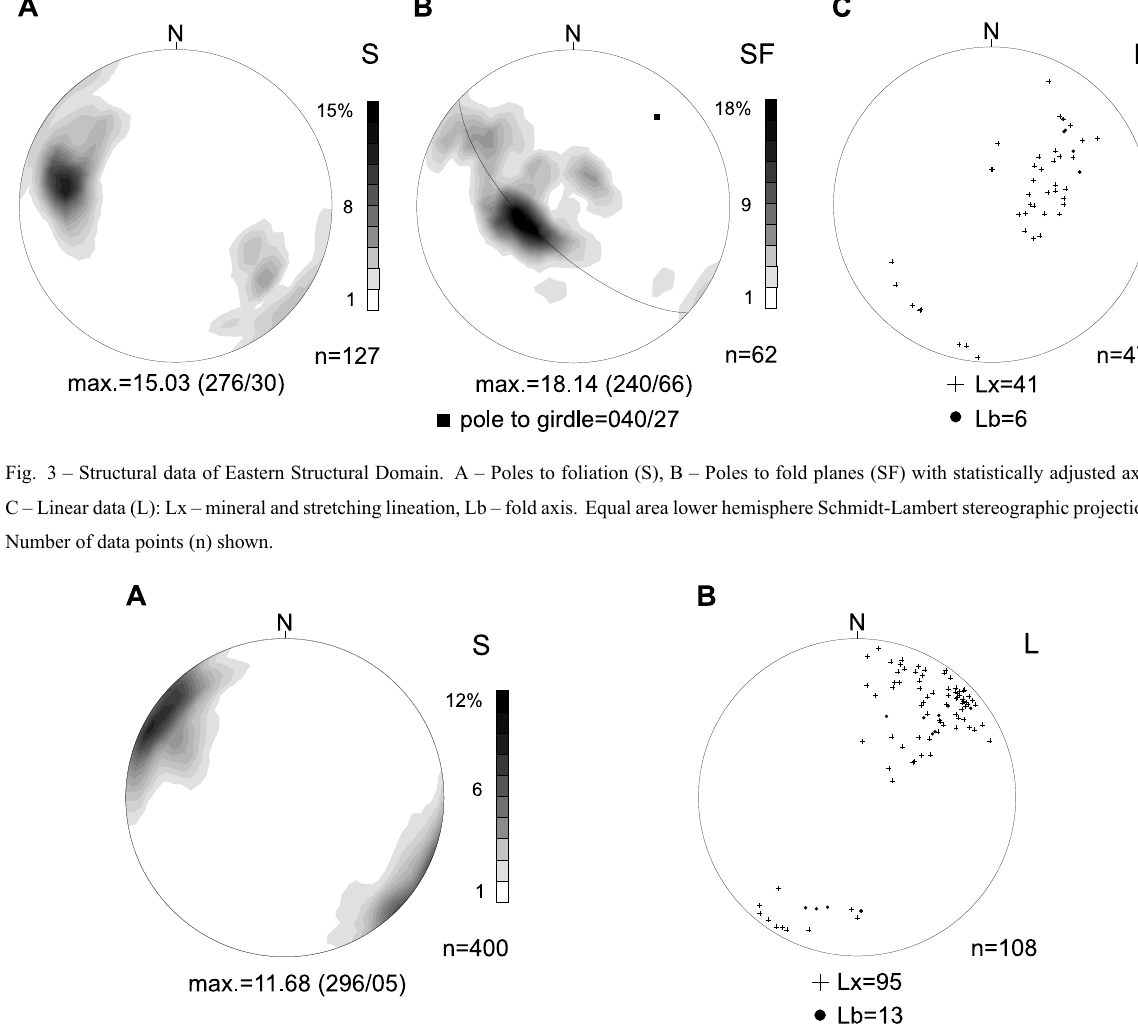
Fig. 4 – Structural data of Central Structural Domain. A – Poles to foliation (S), B – Linear data (L): Lx – mineral and stretching lineation, Lb – fold axis. Equal area lower hemisphere Schmidt-Lambert stereographic projection. Number of data points (n)